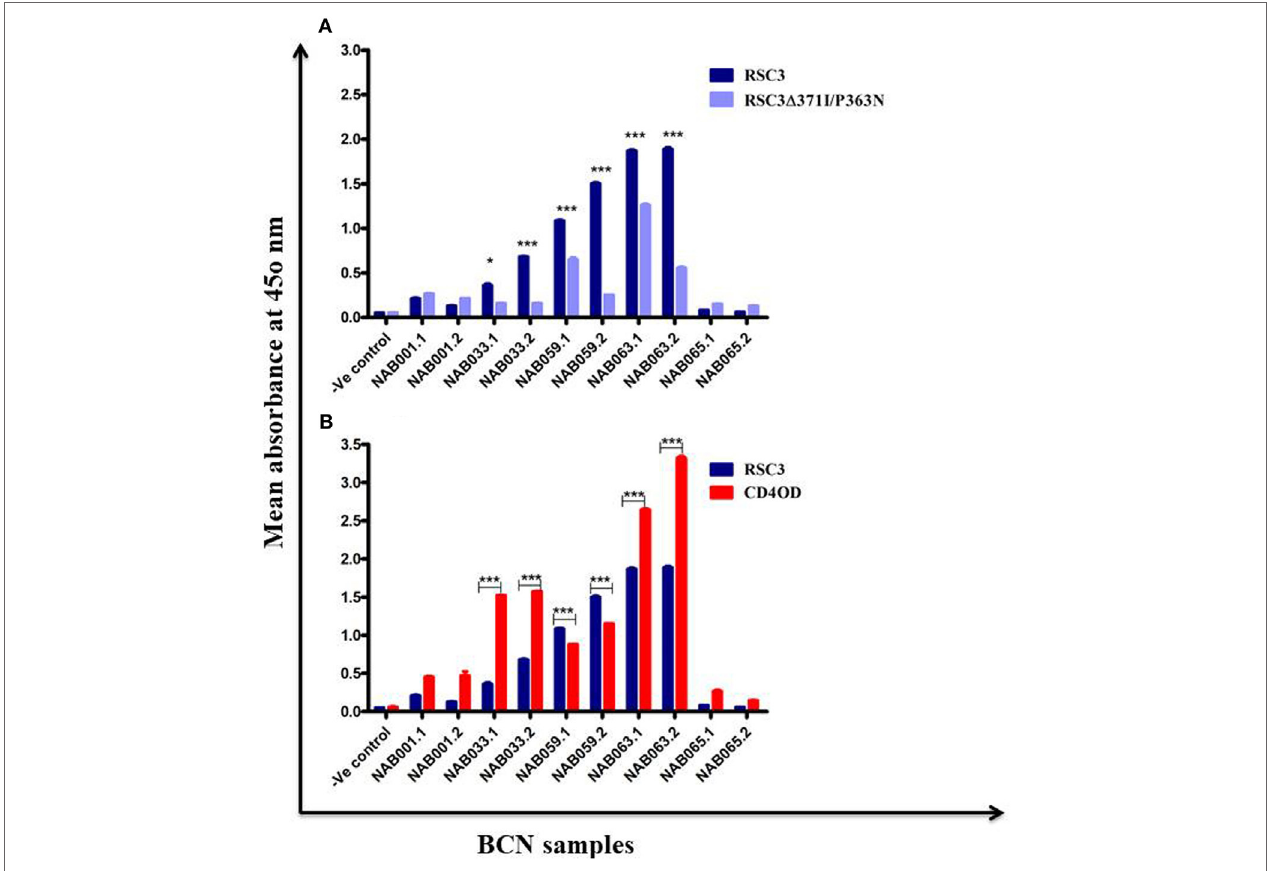
FigUre 5 | ELISA with recombinant RSC3 WT, RSC3 mutant and CD4 outer domain (CD4OD) proteins. (a) ELISA was performed with recombinant wild type RSC3 and double mutant RSC3 Δ 371I/P363N proteins. (B) ELISA was performed with HIV-1 subtype B-CD4OD protein and RSC3 recombinant protein. Each experiment was performed in triplicate on two different occasions. Difference was considered significant if p < 0.05.